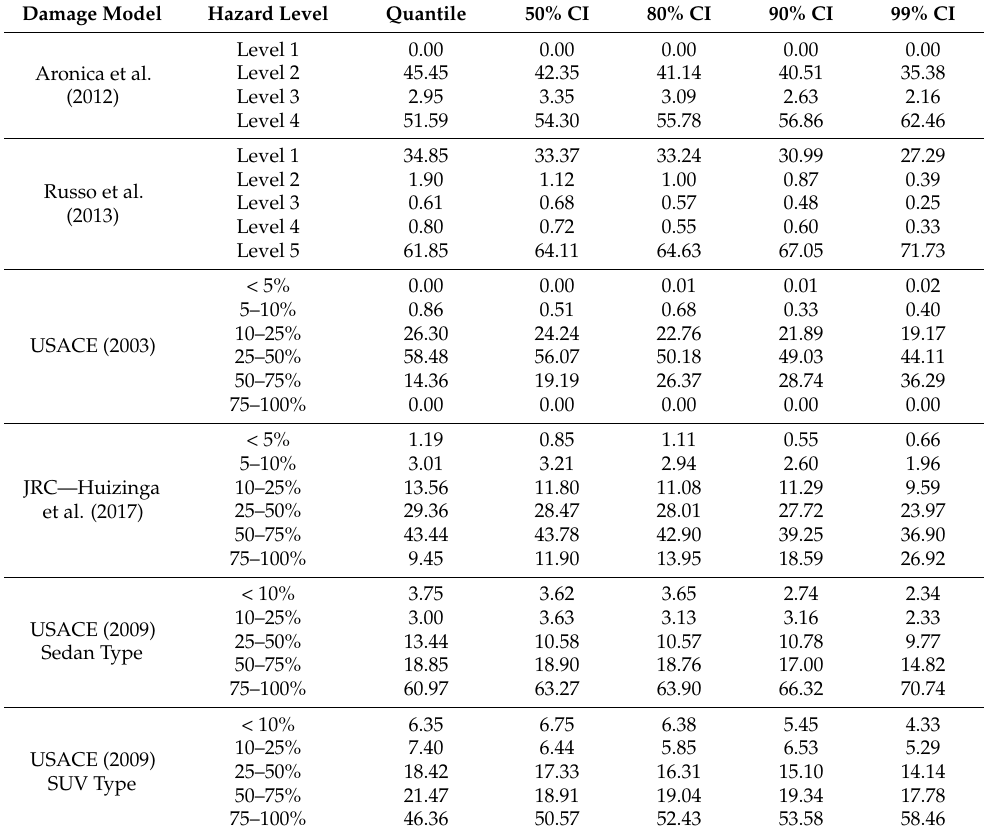
Table 2. Flood hazard areas (%) in the consolidated urban areas at Zamora city; for the damage models (human loss of stability; housing economic losses; damage to vehicles) considered, and their hazard